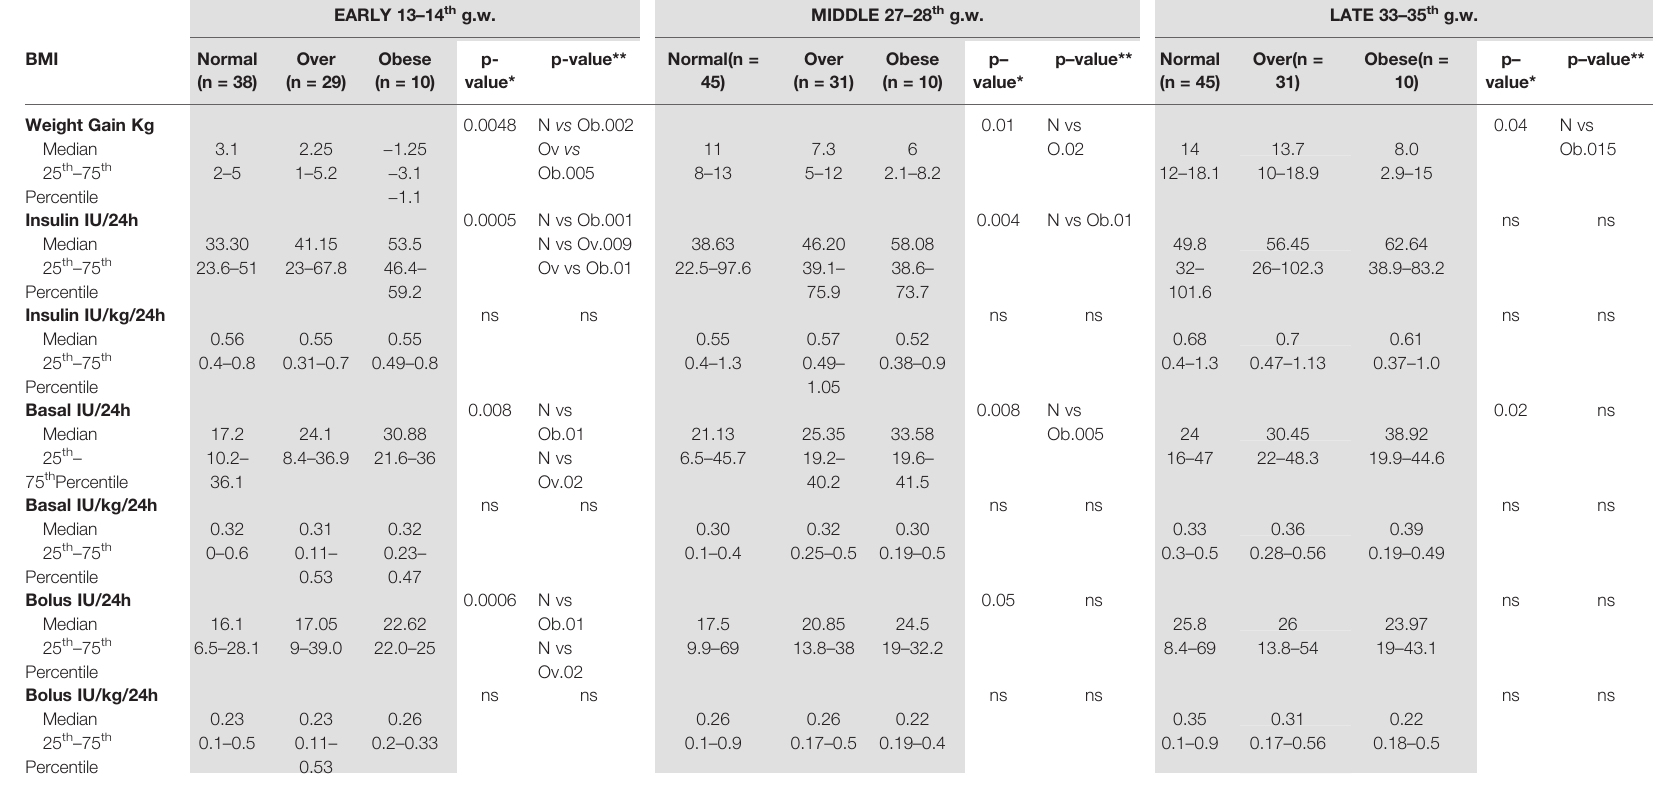
TABLE 3 | Insulin requirement and weight gain: comparison among the three